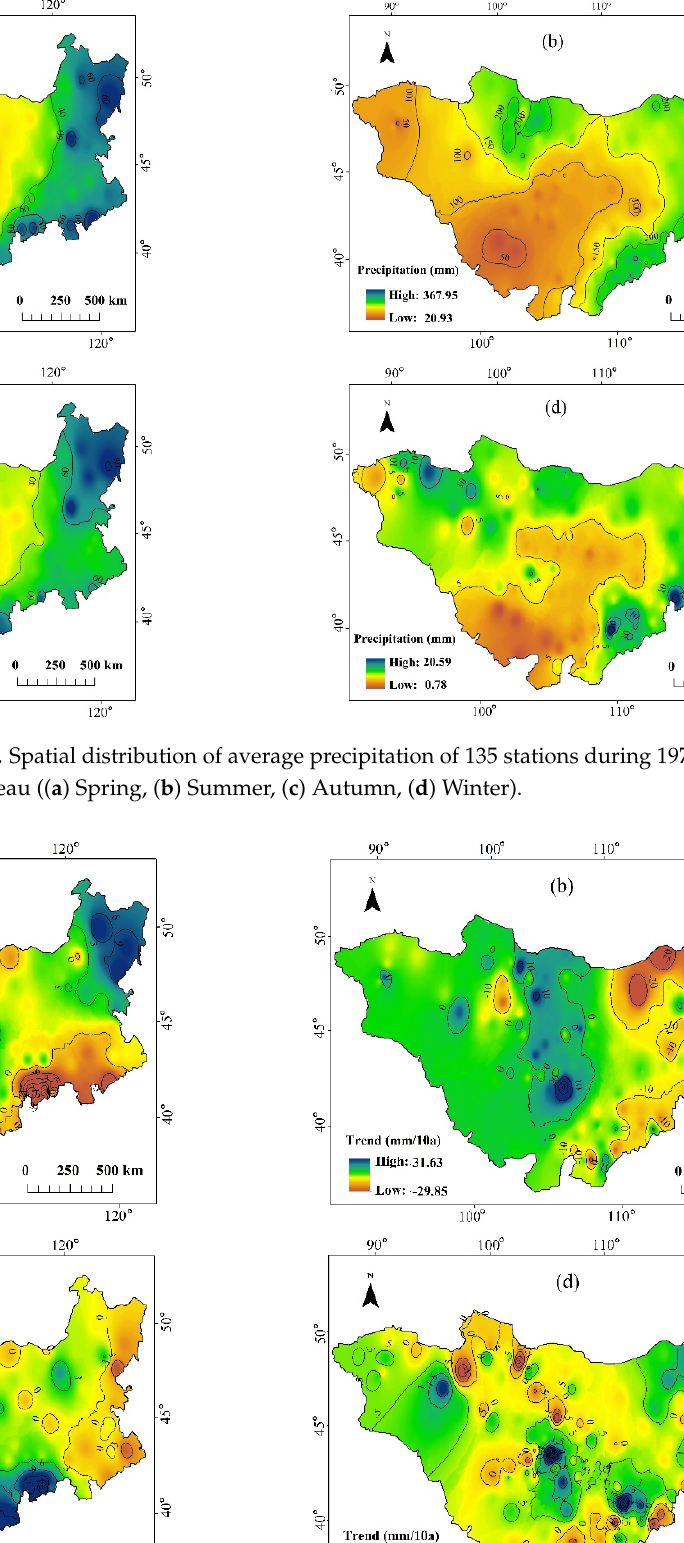
the Mongolian Plateau (( a ) Spring, ( b ) Summer, ( c ) Autumn, ( d ) Winter).